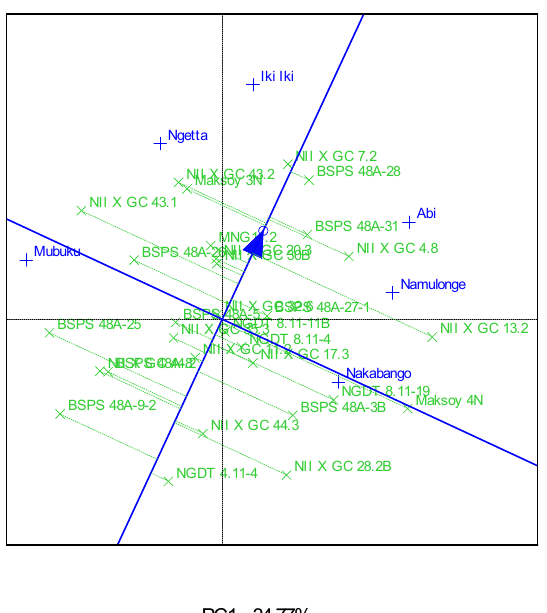
Figure 2. A GGE ranking biplot showing the mean performance and stability for the protein contents of 30 soybean genotypes evaluated in six locations.